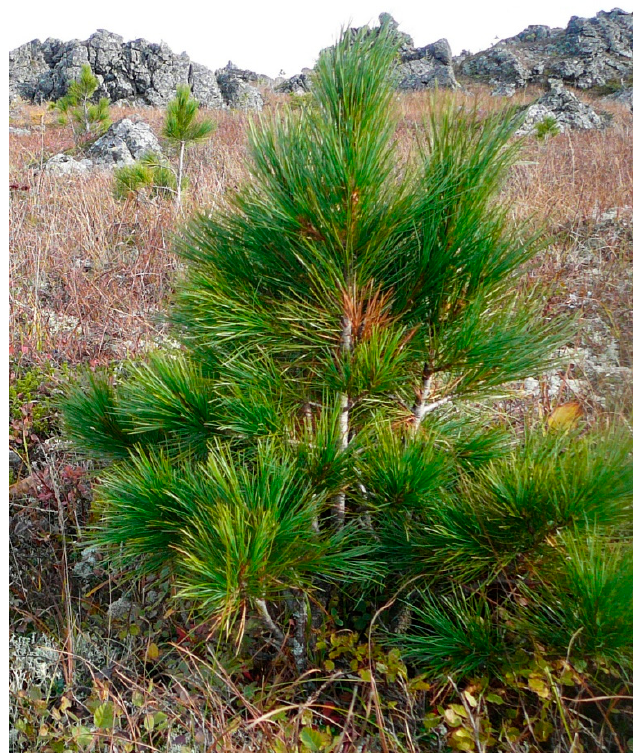
Figure 4. P. sibirica growth characteristics common to the mountain tundra. The tree in the picture is 18 years old and 30 cm in height. The tree crown diameter is 20 cm. The photo was taken by the authors in 2014; photo taken by the authors.